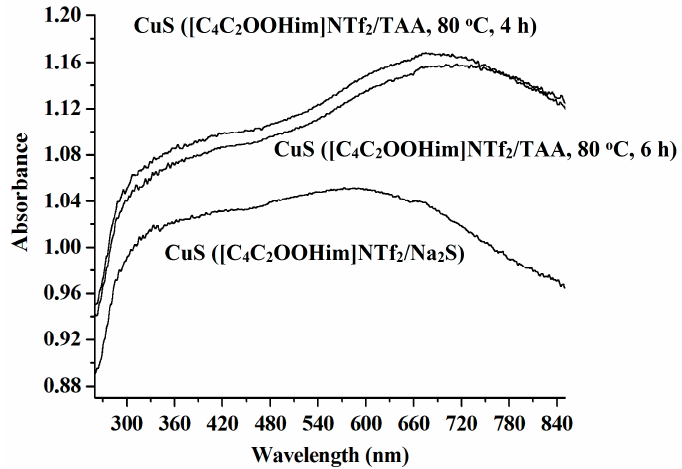
Figure 5. UV/Vis spectra of the CuS nanoparticles prepared in different systems. Figure 5. UV / Vis spectra of the CuS nanoparticles prepared in di ff erent